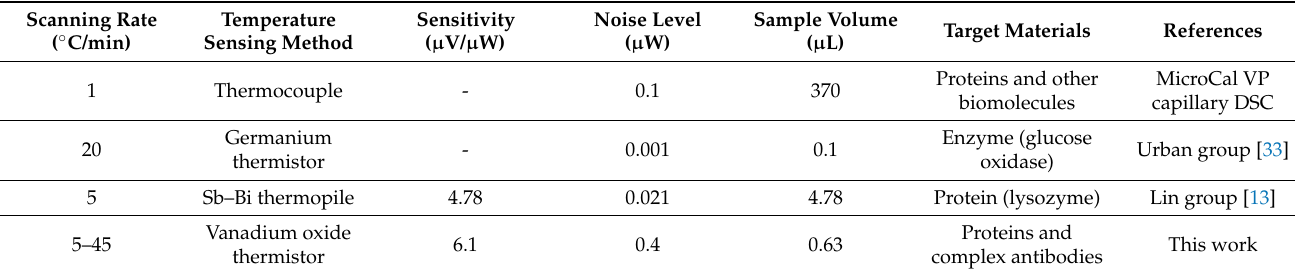
Figure 6. The deconvolution of the normalized DSC curves for the three protein samples. ( a , c , e ) Heat capacity diagrams measured by the MEMS DSC. ( b , d , f ) Heat capacity diagrams measured by the MicroCal VP-DSC. Table 2. Comparison of the MEMS DSC and other existing